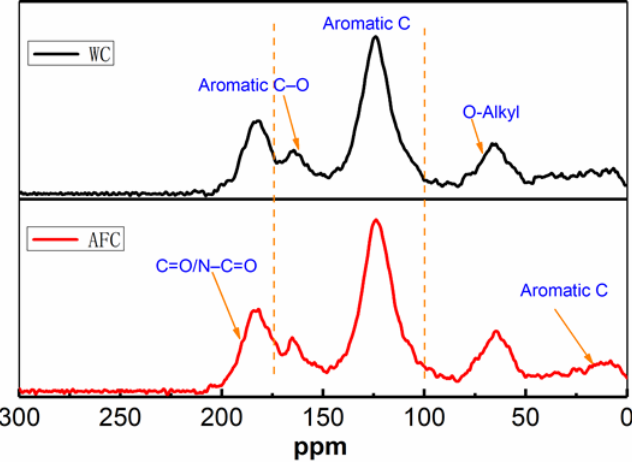
Figure 9. Solid-state 13 C NMR spectra of WC and AFC samples.